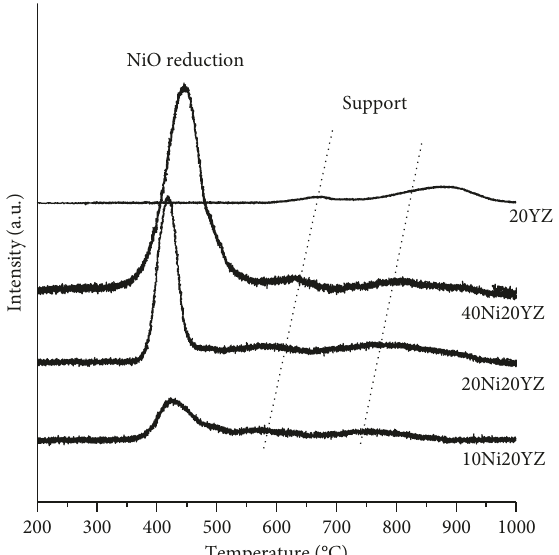
Figure 3: Results for temperature programmed reduction with H (H 2 -TPR) of the catalysts. In the H 2 -TPR analyzes 100mg of catalysts, a gas mixture of 1.96% H 2 /Ar (flow at 30mL a heating rate of 5 ° Cmin were used.